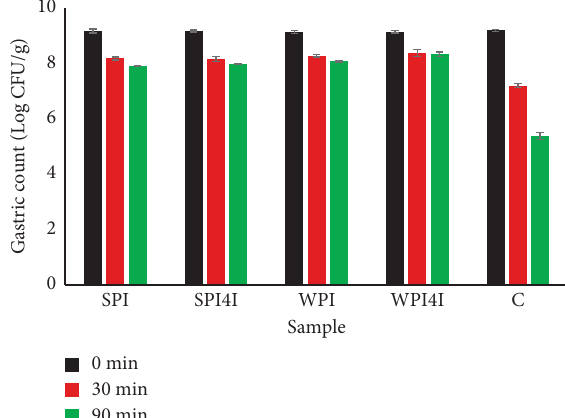
Figure 7: Viability of L. reuteri encapsulated within different wall materials in gastric condition; SPI (soy protein isolate 20%), SPI4I (soy protein isolate 20% +inulin 4%), WPI (whey protein isolate 20%), WPI4I (whey protein isolate 20% +inulin 4%), and C (free bacteria).